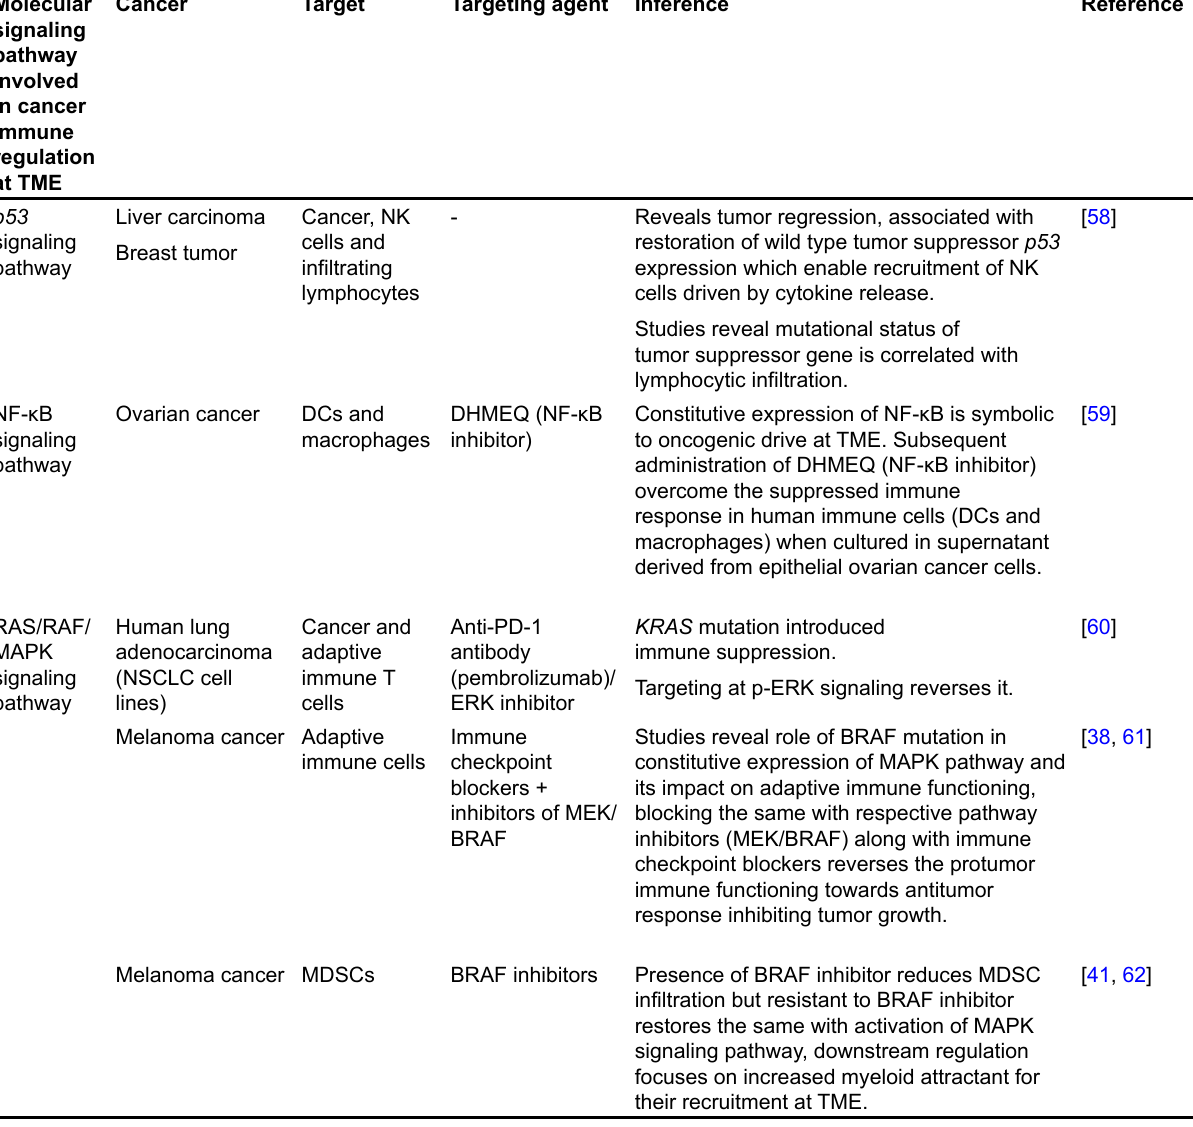
Table 2. Studies from various cancers with molecular cancer immune signaling pathways ( continued )